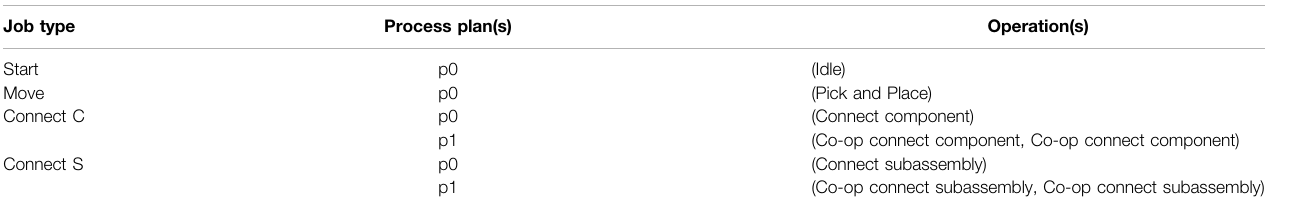
TABLE 6 | Process plans and operations for each of the types of